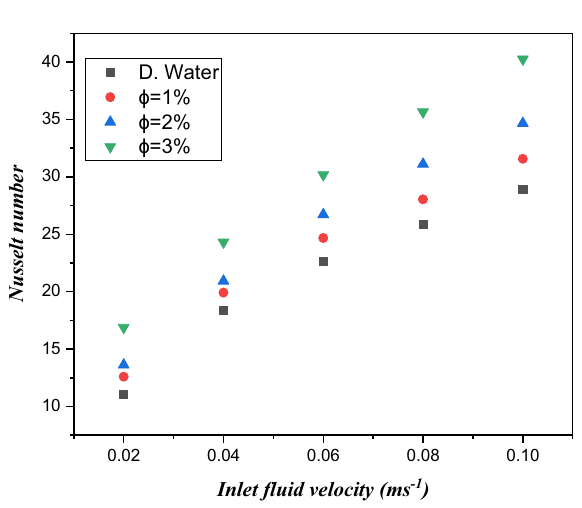
Figure 12. Estimation of the Nusselt number against inlet fluid velocity across the microchannel for an electronic chip heat sink with TiO 2 /water nanofluid and distilled